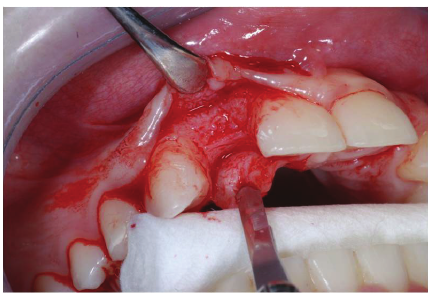
Figure 1: Preoperative clinical condition.